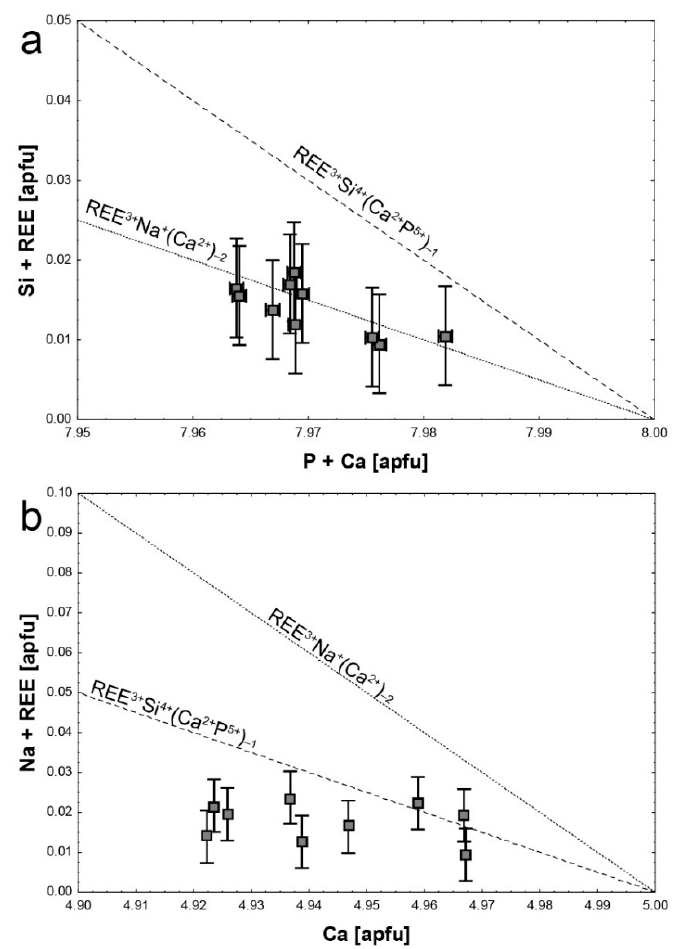
Figure 11. Substitution diagram of hydroxylapatite from Muránska Dlhá Lúka (data points with error bars): ( a ) Ca + P vs. Si + REE; ( b ) Ca vs. Na + REE. Dashes and dotted lines represent ideal trend of specified substitutions.